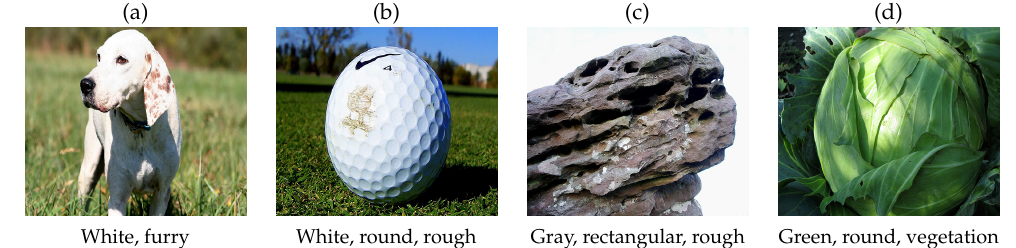
Figure 5. Predicted results of middle-level attributes of non-human objects.